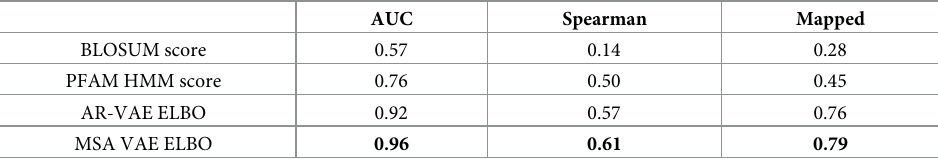
Table 1. Metrics assessing ability of model scores to predict experimental luminescence values.